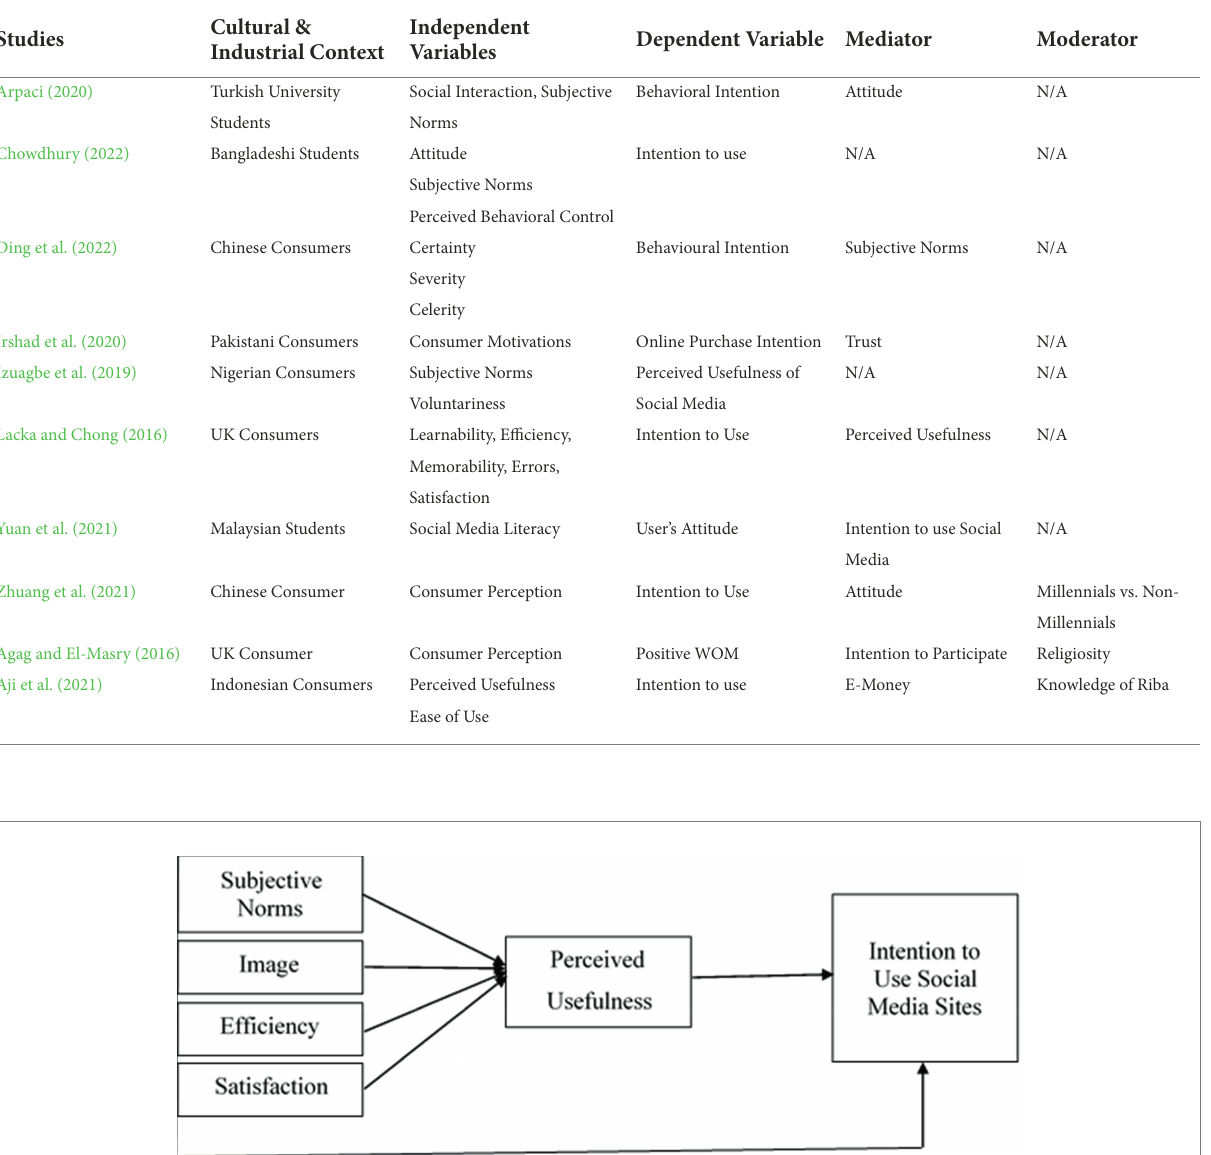
TABLE 1 A summary of existing social media studies.